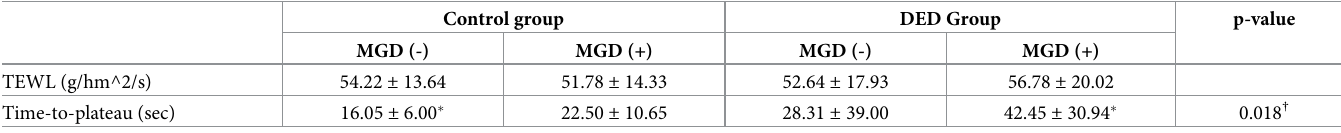
Table 2. Comparison of TEWL and time-to-plateau between the two groups according to the existence of